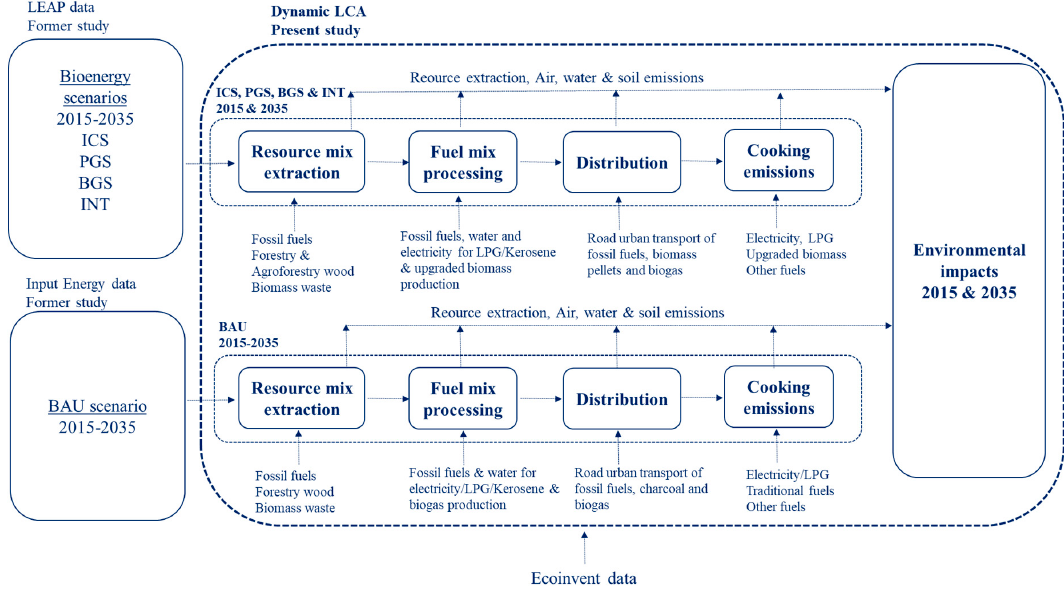
Figure 1. Overall description of the dynamic LCA method applied based on input data generated in the previous LEAP study (Original figure designed by the author).